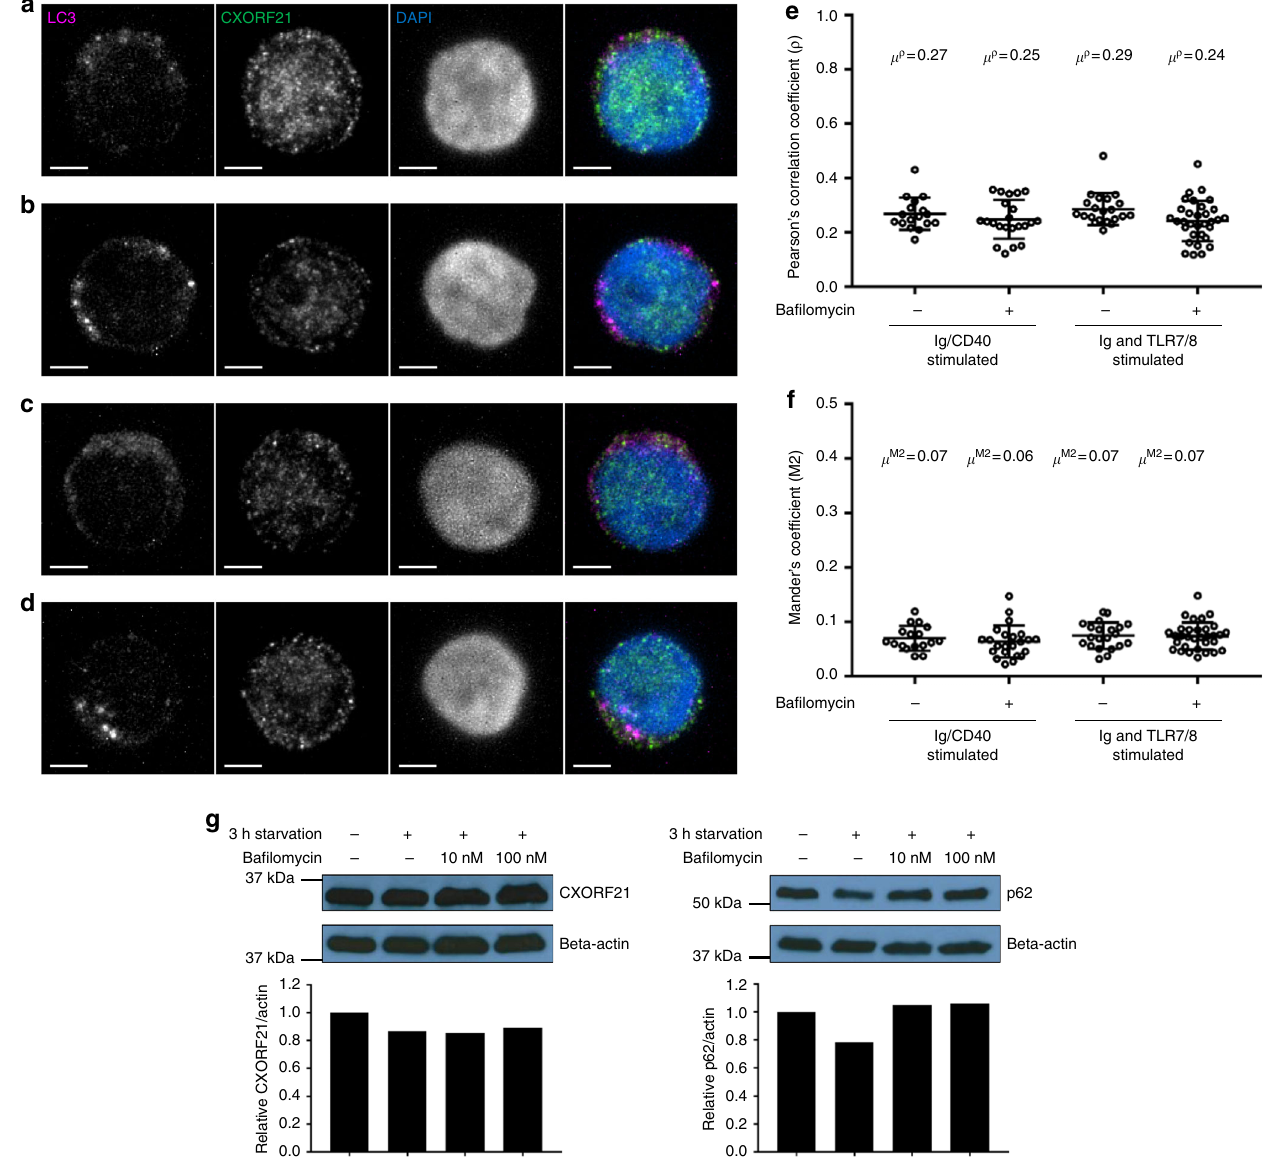
Fig. 7 CXORF21 and the autophagosome. Structured Illumination Microscopy data showing colocalisation of LC3 and CXORF21 in ex vivo B cells. Representative results on individual cells are shown in panels a through d with LC3 staining in the fi rst column, CXORF21 in the second column, DAPI nuclear staining in the third column, and in the fourth column all three stains are merged: LC3 (magenta), CXORF21 (green) and DAPI (blue). In panel a B cells were Ig/CD40 stimulated, b Ig/CD40 stimulated and ba fi lomycin-treated, c Ig and TLR7/8 stimulated and d Ig and TLR7/8 stimulated and ba fi lomycin-treated after 27 h. Maximum intensity projections are shown. Scale bar in white on bottom left hand corner is 2 µ m. e Plot showing the correlation co-ef fi cients ( ρ ) between LC3 and CXORF21 staining quanti fi ed using the results from Z-stack images, individual B cells are represented as open circles. From left to right: Ig/CD40 stimulated cells ( n = 17), Ig/CD40 stimulated cells in the presence of 10 nM ba fi lomycin ( n = 22), B cells stimulated with Ig and resiquimod ( n = 21), B cells stimulated with Ig and resiquimod in the presence of 10 nM ba fi lomycin ( n = 32). The horizontal bar represents the mean correlation co-ef fi cient ( μ ρ ) and the bars above and below this horizontal bar denote the standard deviation of the distribution. f Mander ’ s colocalisation coef fi cient (M2) between LC3 and CXORF21 are shown from Z-stack images, individual B cells are represented as open circles. From left to right: Ig/CD40 stimulated cells ( n = 17), Ig/CD40 stimulated cells in the presence of 10 nM ba fi lomycin ( n = 23), B cells stimulated with Ig and resiquimod ( n = 21), B cells stimulated with Ig and resiquimod in the presence of 10 nM ba fi lomycin ( n = 32). The horizontal bar represents the mean colocalisation co- ef fi cient ( μ M2 ) and the bars above and below this denote the standard deviation of the distribution. g Western blot analysis of protein extract from starved LCL, in the left-hand blot CXORF21 is quanti fi ed in the absence of ba fi lomycin and after 10 nM and 100 nM treatment. The amount of CXORF21 was quanti fi ed by densitometry and the relative abundance shown against a beta actin control, using the unstimulated conditions as a reference point. In the right-hand blot sequestosome 1 (p62) is quanti fi ed in the absence of ba fi lomycin and after 10 nM and 100 nM treatment. The amount of Sequestosome-1 was quanti fi ed by densitometry and the relative abundance shown against a beta actin control, using the unstimulated conditions as a reference point. Source data are provided as a Source Data fi